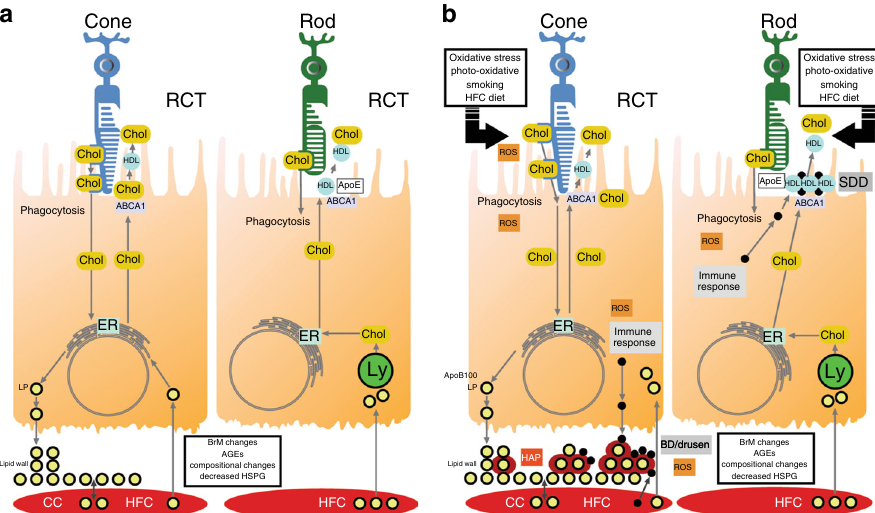
Fig. 3 Schema of the role of lipids in drusen and subretinal drusenoid deposit formation. a In the cone-rich fovea, the high cholesterol content of cones, along with lipids derived from the circulation due to a high cholesterol diet, induces apoB100 lipoprotein formation that is basally secreted. Due to age- related Bruch ’ s membrane changes, lipoproteins accumulate, forming the lipid wall. In the rod-rich parafovea, reverse cholesterol transport mediated through ABCA1 releases cholesterol to apoE and apoA1, forming high-density lipoproteins for the recycling of lipids including docohexanoic acid and cholesterol to rods. b Hydroxyapatite forms around retained lipids and lipoproteins, and combined with lipoprotein oxidation, induces an in fl ammatory response with the accumulation of in fl ammatory debris, leading to basal deposit and drusen formation. In the subretinal space, dysfunction of reverse cholesterol transport can lead to lipid accumulation, which induces an in fl ammatory response, forming subretinal drusenoid deposits. AGEs advanced glycation endproducts, BD basal deposit, BrM Bruch ’ s membrane, CC choriocapillaris, CEP carboxyethyllysine, Chol cholesterol, ER endoplasmic reticulum, HAP hydroxyapatite, HDL high-density lipoprotein, HFC high-fat cholesterol diet, HSPG heparan sulfate proteoglycan, Lp apoB100 containing lipoprotein, Ly lysosome, Mono/macro monocyte/macrophage, RCT reverse cholesterol transport, ROS reactive oxygen species, SDD subretinal drusenoid deposit; yellow circle surrounded by red, apoB100 containing lipoprotein with surrounding